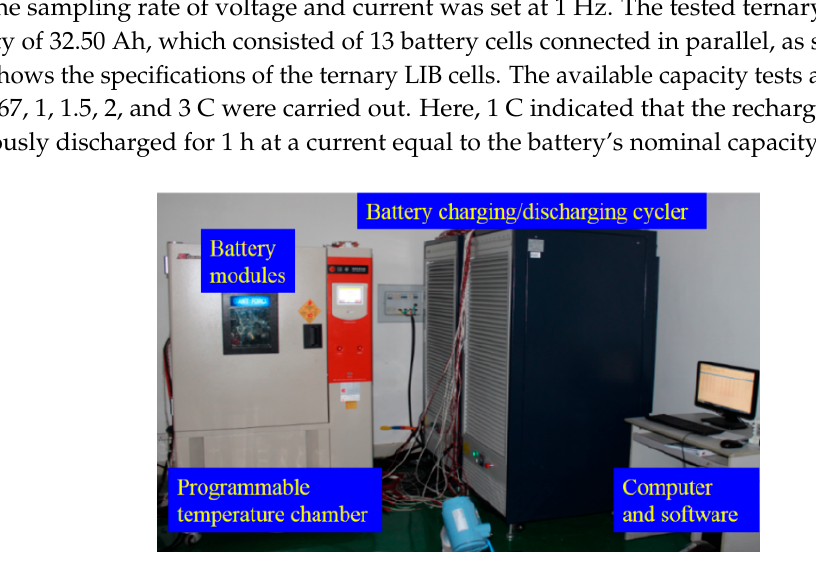
Electronics 2019 , 8 , x FOR PEER REVIEW Figure 4. The battery test experimental platform. Figure 4. The battery test experimental platform. Table 1. Specification of the ternary lithium-ion battery (LIB) cell.